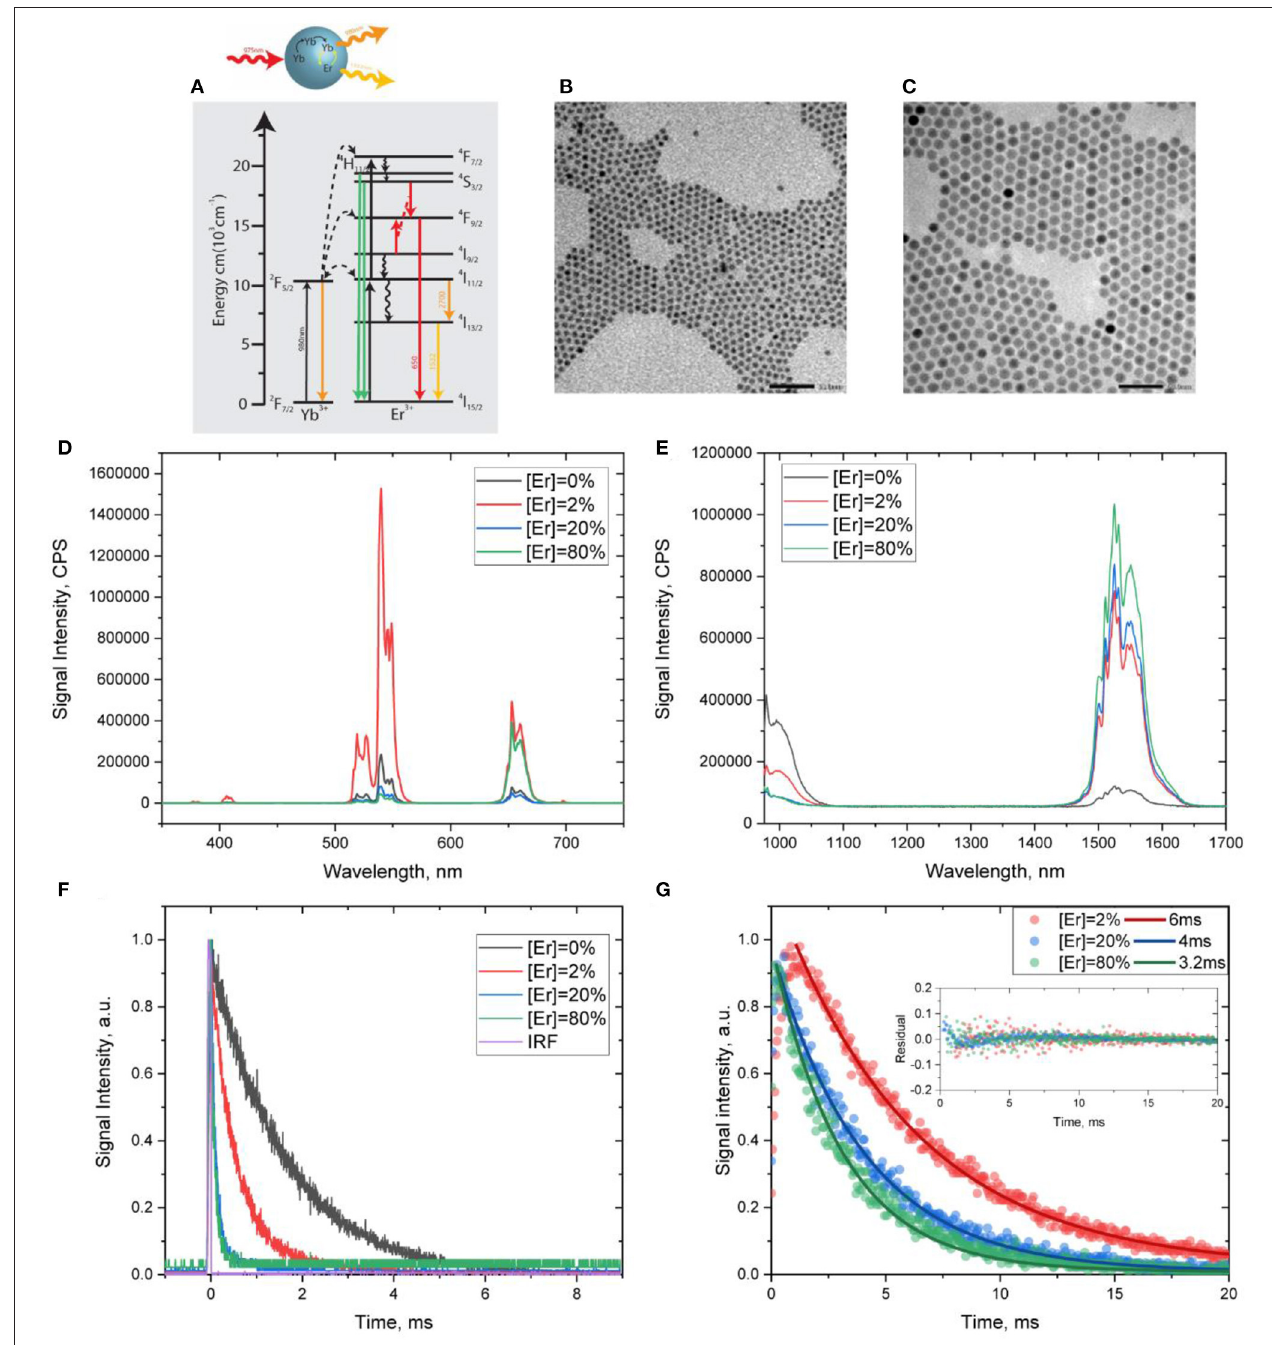
FIGURE 2 | (A) Scheme of energy levels along with activation/deactivation pathways in Yb 3 + /Er 3 + co-doped nanoparticles. (B,C) Representative TEM images of NaYF 4 : Yb 3 + , Er 3 + core and NaYF 4 :Yb 3 + ,Er 3 + @NaYF 4 core@shell RENPs, respectively. (D,E) UC PL and DC PL spectra of NaYF 4 :Yb 3 + ,Er 3 + @ NaYF 4 core@shell nanoparticles under 975-nm excitation. (F) PL decays acquired at 1,000nm (Yb 3 + emission), (G) DC PL decays acquired at 1,530nm (Er 3 + emission), along with the monoexponential fits and corresponding